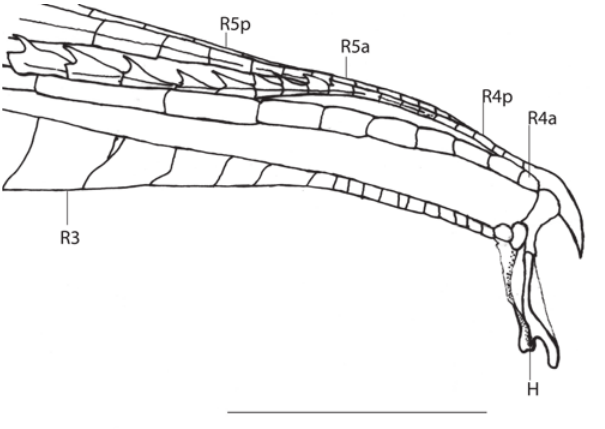
Fig. 24. Gonopodium tip of Phalloceros enneaktinos , MCP 30510. R3, R4a, R4p, R5a, R5p indicate gonopodial rays. Scale bar 1